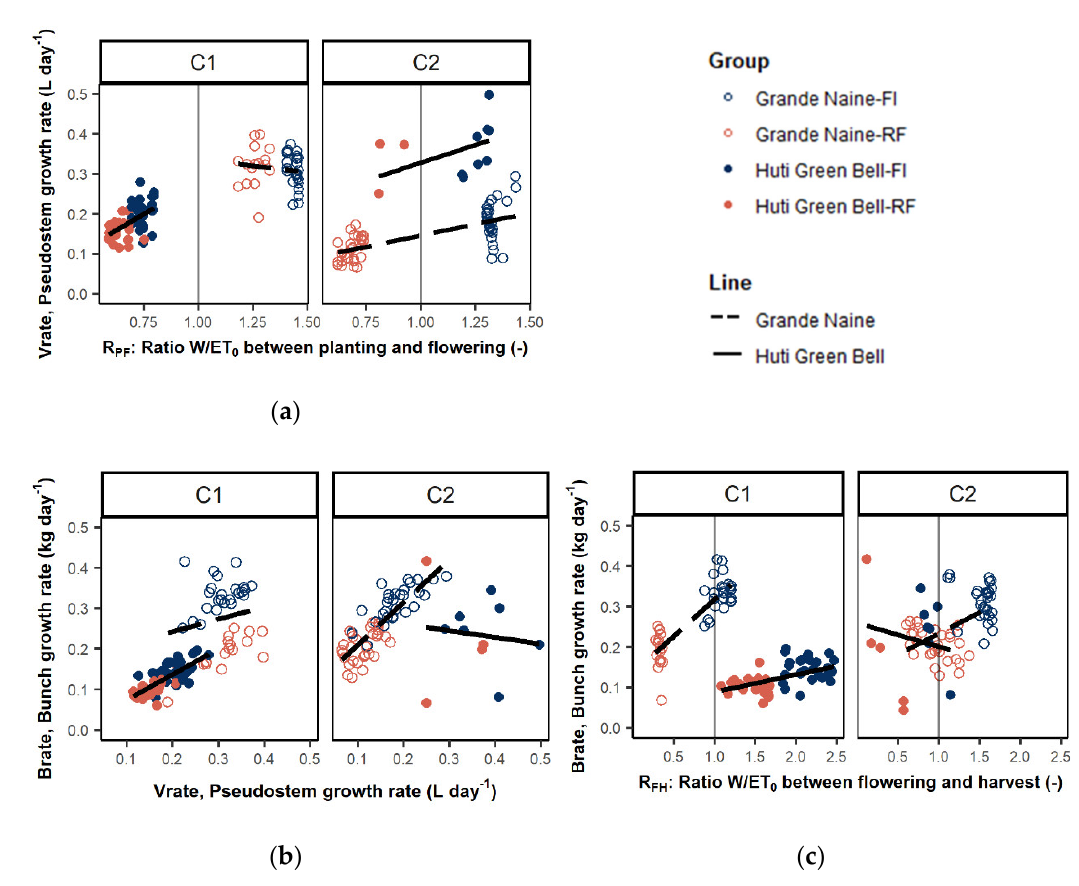
Figure 2. Effect of moisture and ET 0 on growth rates. ( a ) V rate , pseudostem growth rate (L day −1 ) vs. R PF , Ratio of cumulative water added (W) and cumulative ET0 between planting and flowering; ( b ) B rate , bunch growth rate (kg day −1 ) vs. V rate (L day −1 ) specifying the effect of earlier vegetative growth on bunch rates; and ( c ) B rate vs. R FH , Ratio of cumulative water added (W) and cumulative ET0 between flowering and harvest. Dots note observations for individual plants. Lines note regression lines for each cultivar-cycle group. C1 and C2 note C1 and C2 respectively. FI notes full irrigation, RF notes rainfed.